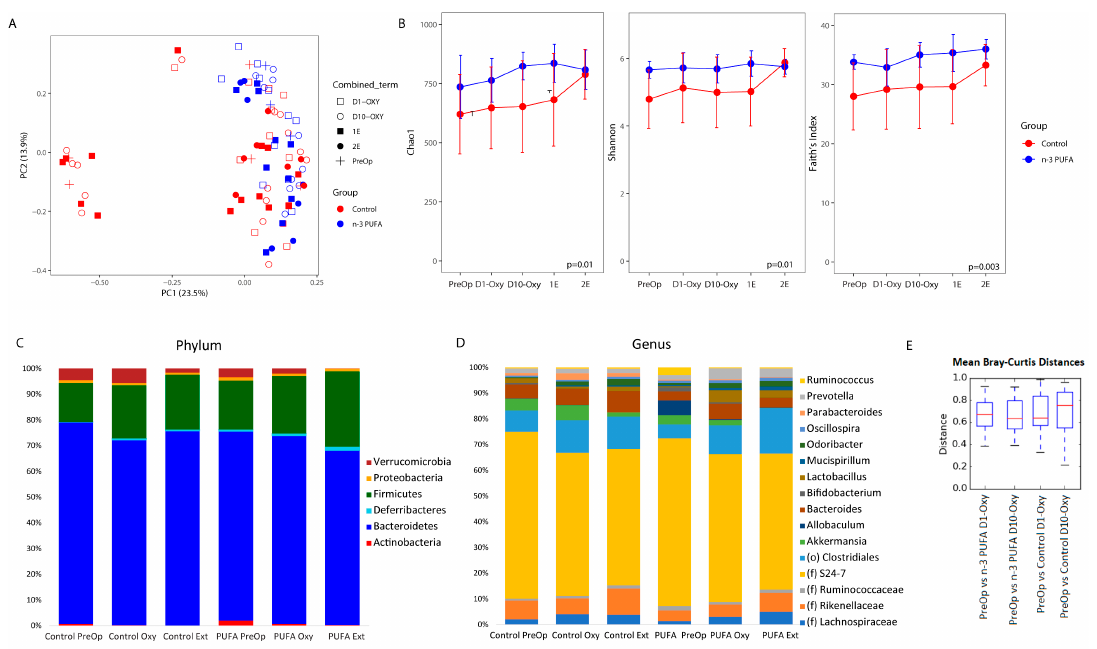
Figure 3. n-3 PUFA supplementation and opioid extinction altered gut microbiome profiles. ( A ) Principal coordinate analysis plot separated by diet and study phase (D1-OXY: Day 1 of oxycodone; D10-OXY: Day 10 of oxycodone; 1E: First extinction phase, 2E: Second extinction phase). Each symbol represents one fecal sample, with color denoting the dietary group and shape denoting the phase. The axis labels indicate the percentage of variation represented by each coordinate. ( B ) Microbial composition and diversity. Species richness (Chao1) ( left ), species evenness (Shannon Index) ( middle ), and phylogenetic diversity ( right ) by diet (control diet in red and n-3-PUFA-enriched diet in blue). ( C ) Phylum and ( D ) genus summary by groups. Bar plots show the average relative abundance of microbes at the phylum and genus levels. D1-OXY and D10-OXY were combined, as were 1E and 2E. ( E ) Bray–Curtis distances between